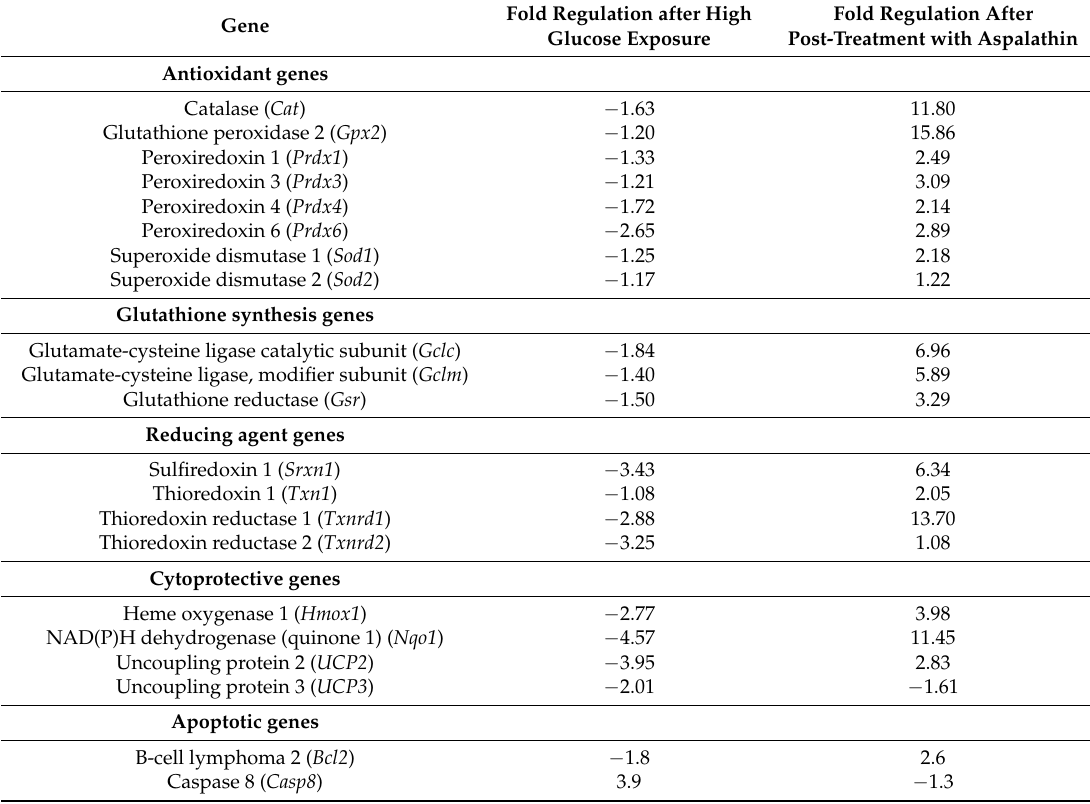
Table 1. Aspalathin treatment (1 µ M) increased the expression of antioxidant genes and phase II cytoprotective enzymes in H9c2 cardiomyocytes pre-exposed to 33 mM glucose for 48 h. Fold Regulation after High Fold Regulation After Gene Glucose Exposure Post-Treatment with Aspalathin Antioxidant